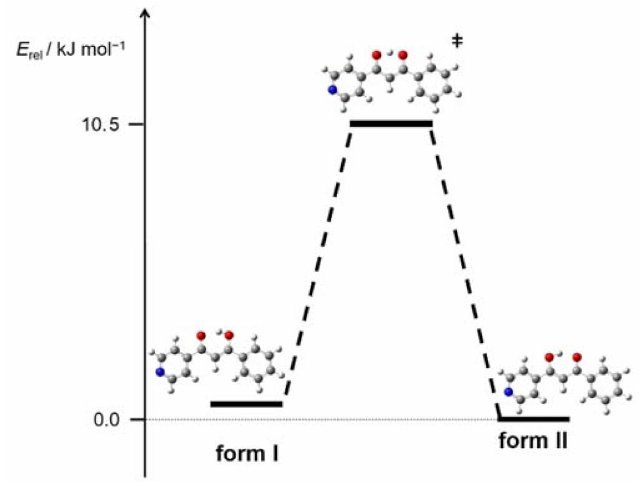
Figure 9. The relative energy of b4pm form I, form II and transition